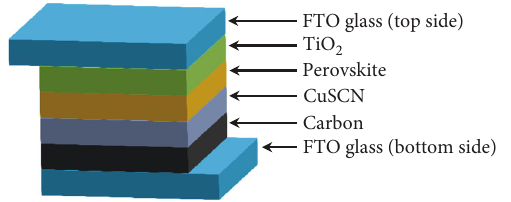
Figure 1: Structure of fabricated